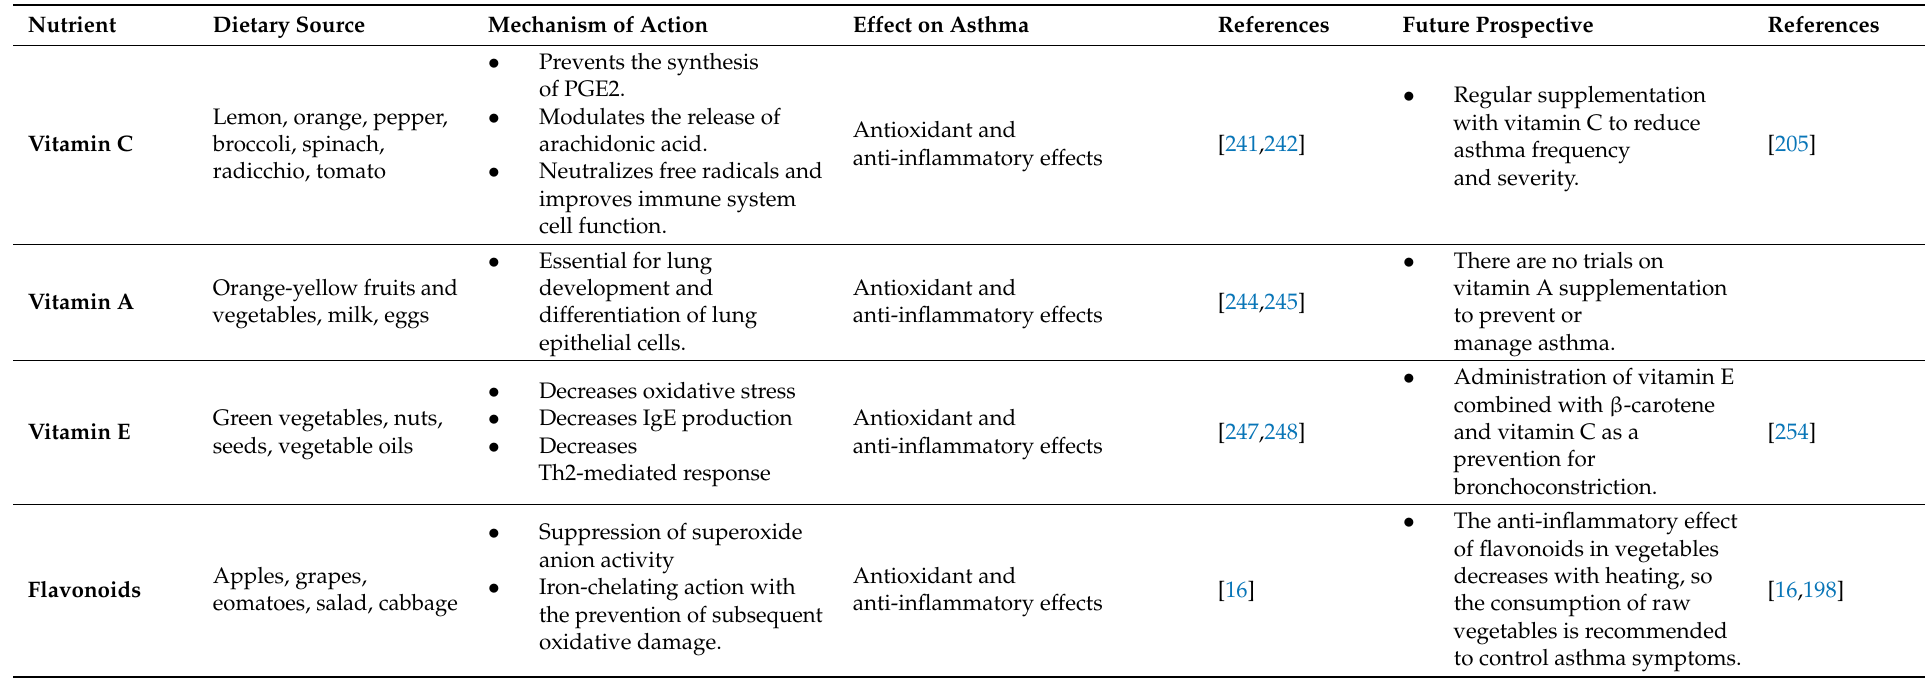
Table 1. Summary of current evidence and future perspectives on antioxidants with beneficial effect on